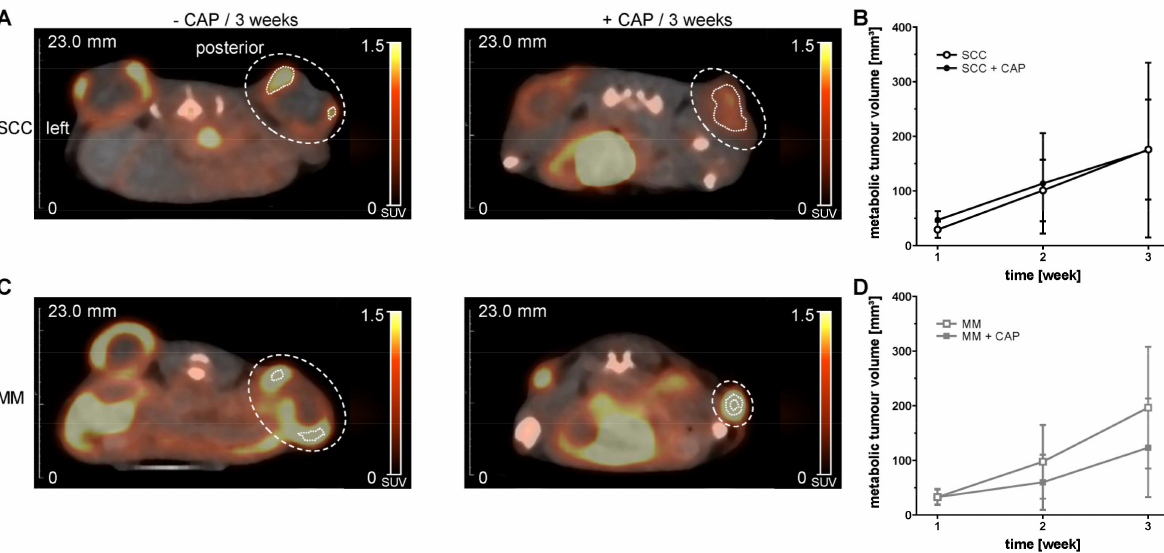
Figure 3. Representative PET/CT images from [ 18 F]FDG ( A , C ; summed images, axial slices) and quantitative assessment of metabolic tumour volumes ( B , D ). NSG mice with two s.c. flank tumours, either squamous cell carcinoma (SCC) or malignant melanoma (MM), were treated with or without cold atmospheric pressure plasma (CAP) over three weeks. CAP treatment started four days after tumour cell injection and was repeated every four days. Data are presented as mean ± SD ( n = 6–20 samples per time point); mixed-effects analysis, followed by Bonferroni correction. Large, dotted line mark manually placed volume of interest. Short, dotted line mark right metabolic tumour volume.